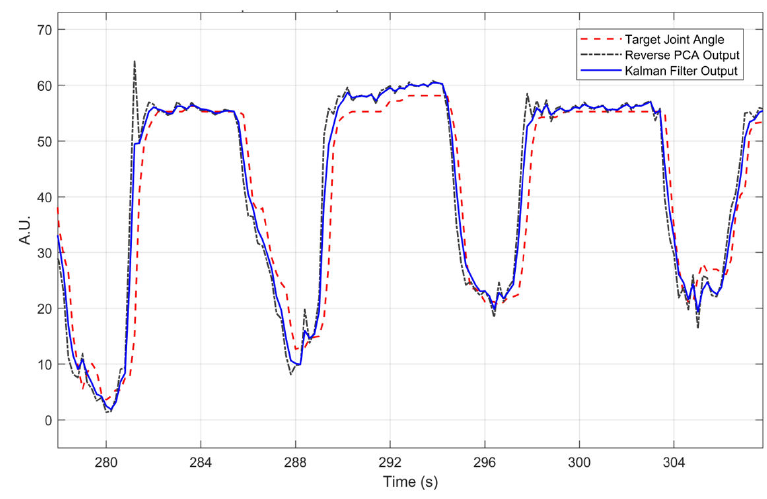
Figure 11. Comparison of output signals after post-processing.